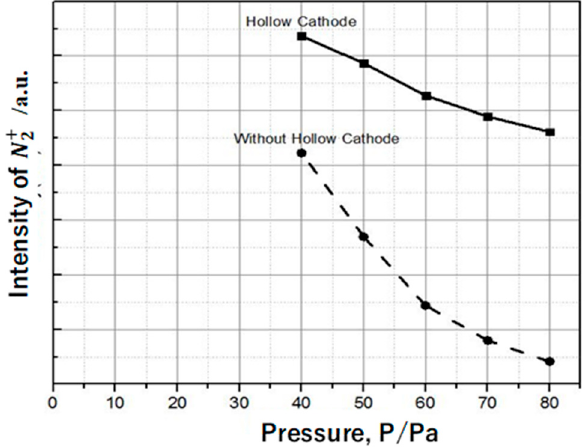
Figure 3. Variation in N (cid:2870)(cid:2878) peak intensity with the increase in pressure in the plasma diagnosis, with and without the use of the hollow cathode device in case where V RF = 250 V and V DC = − 500 V.